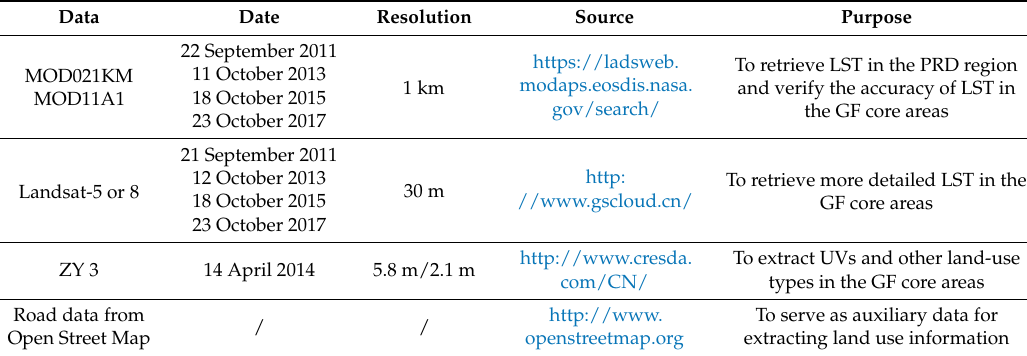
Table 1. Overview of the multitemporal